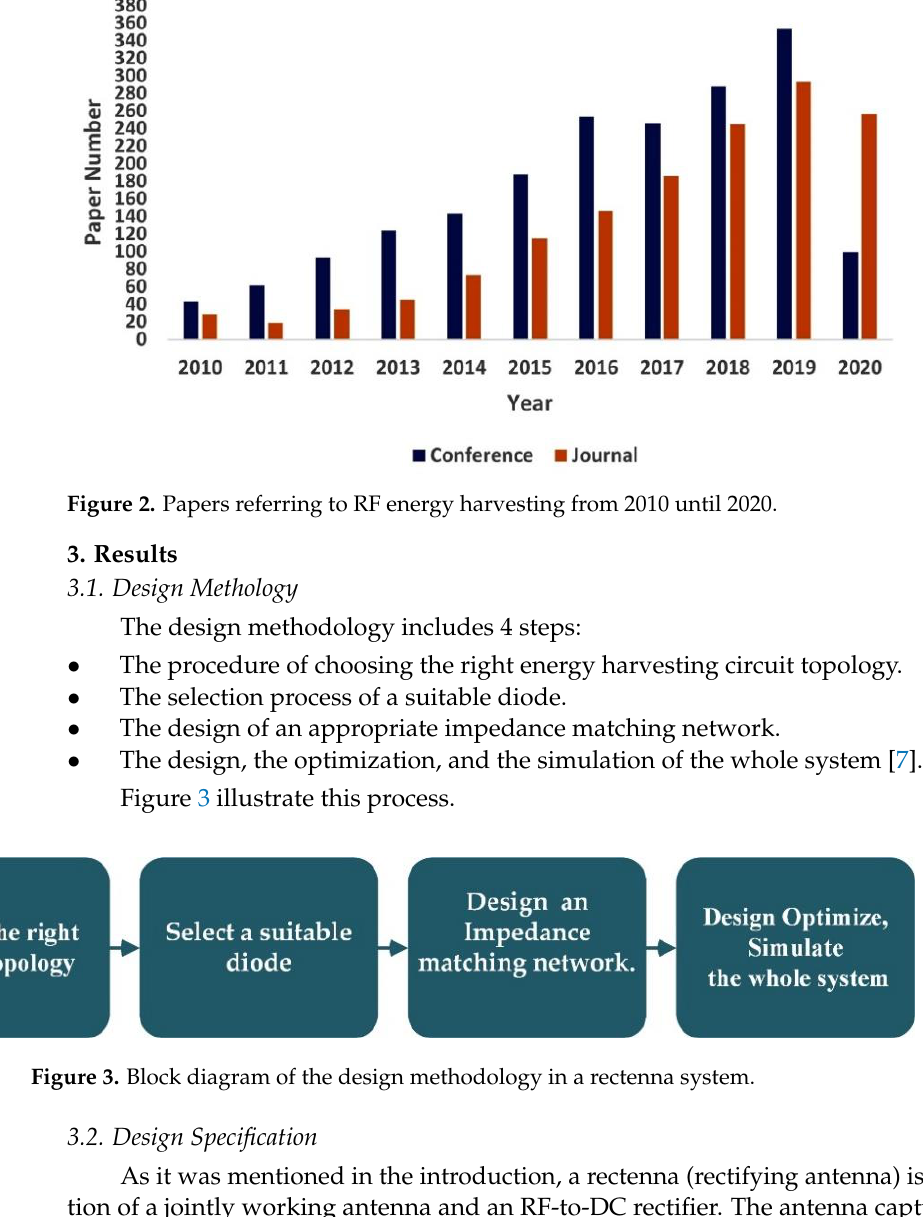
Figure 3. Block diagram of the design methodology in a rectenna system.